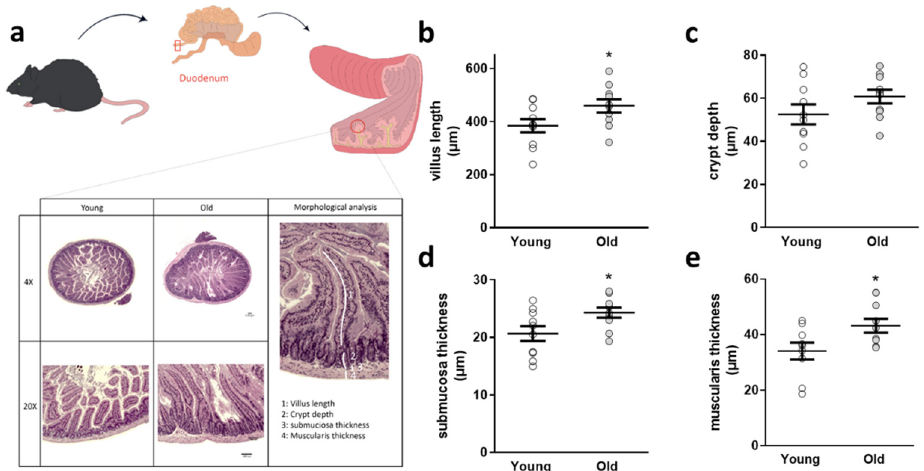
Figure 2. Duodenal architectural parameters assessed in 5xFAD mice after FMT. ( a ) Duodenal sections were stained with HE and villus length ( b ), crypt depth ( c ), submucosal thickness ( d ), and muscularis thickness ( e ) measured. Exemplary sections are shown for each group. Two slides per animal ( n = 10 animals per group; 5 female) were used and four villi and neighboring structures taken into account per slide. (*, p < 0.05). Data are presented as mean ± SEM. Single data points present the mean of all technical values derived from one animal (“young”: 5xFAD treated with cecal material from young wt mice; “old”: 5xFAD treated with cecal material from old wt